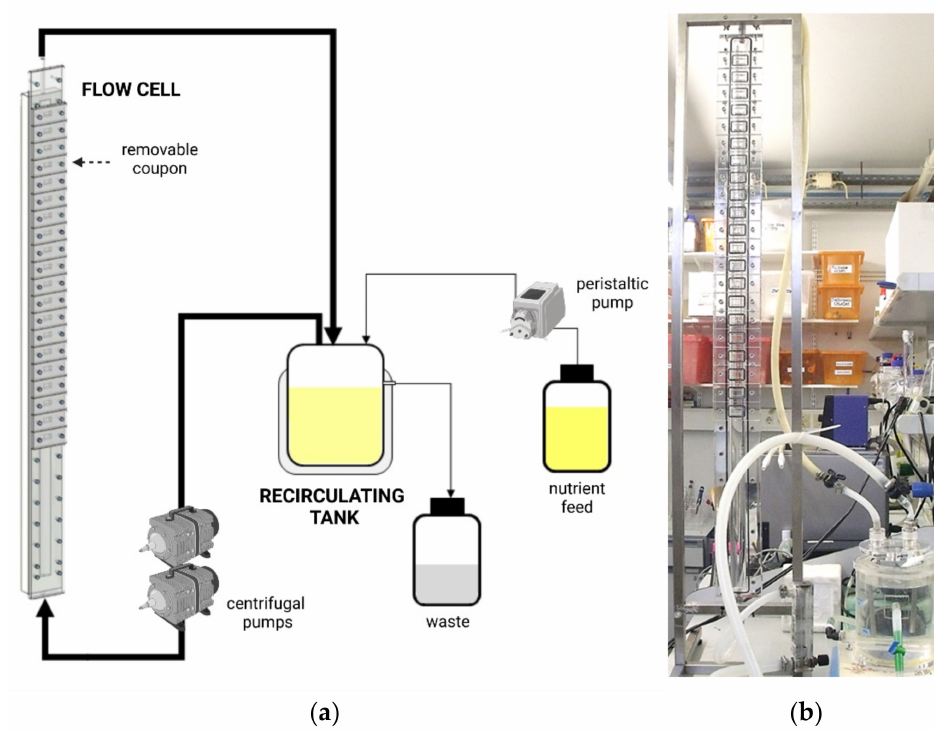
Figure 1. Modified Robbins device with the fluid behavior fully characterized by CFD: ( a ) schematic representation and ( b ) photograph. The system is mainly composed of a recirculating tank and one vertical semi-circular flow cell (about a meter high) with removable coupons, as well as peristaltic and centrifugal